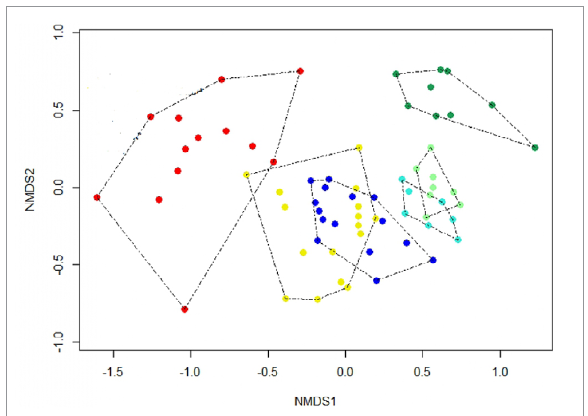
Figure 8: Non-metric multidimensional scaling (NMDS) based on the presence and absence matrix approximates the locations with the composition of ants most similar to each other. Forest (green), soy monoculture (red), pasture (blue), Kubos (light green), Campo (cyan), and organic agriculture (yellow) species.